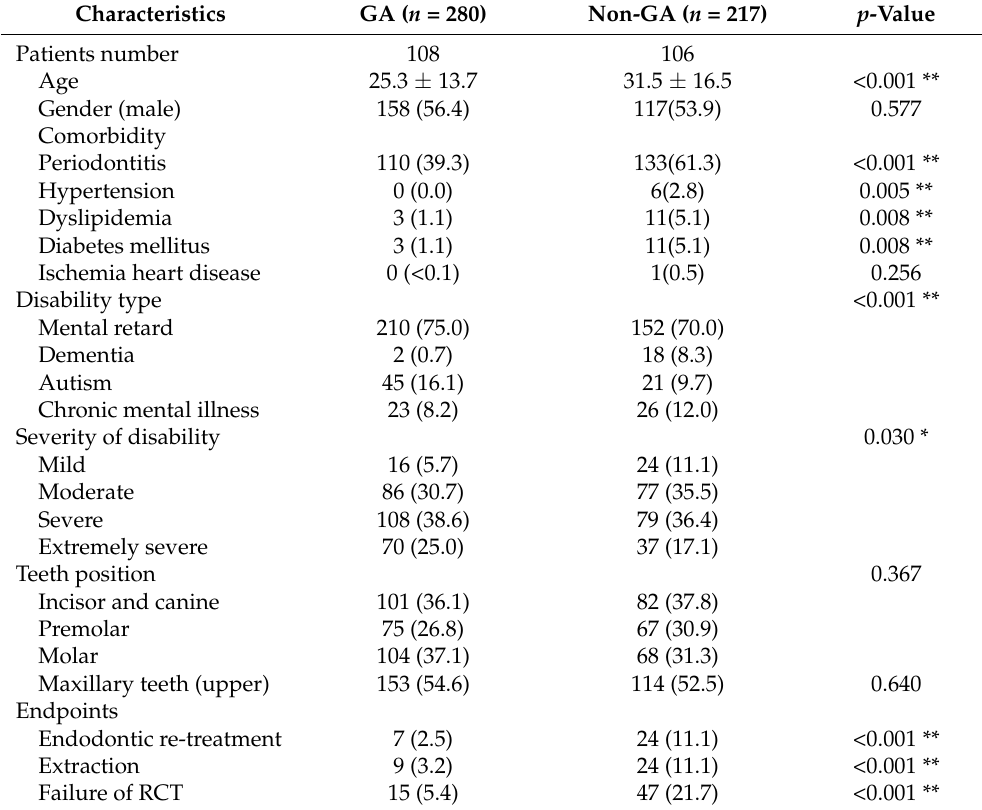
Table 1. Comparisons of characteristics between RCT patients with and without general